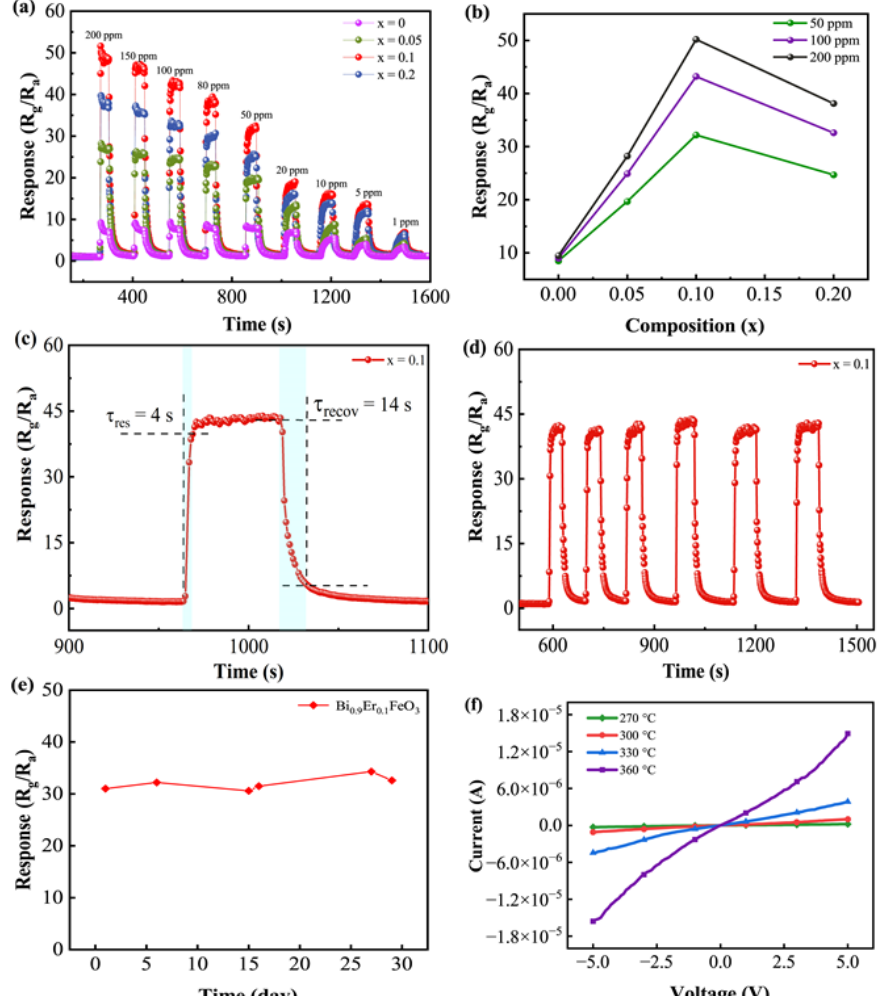
Figure 6. ( a ) Dynamic response and recovery curves of Bi 1 − x Er x FeO 3 sensors to acetone. ( b ) Re- sponse of sensors as a function of Er-doping content. ( c ) Transient response of Bi 0.9 Er 0.1 FeO 3 sensor to 100 ppm acetone. ( d ) The response to 100 ppm acetone measured for six cycles. ( e ) Stability measure- ment of Bi 0.9 Er 0.1 FeO 3 sensor to 50 ppm acetone within a month. ( f ) Current-voltage characteristics of Bi 0.9 Er 0.1 FeO 3 sensor at different